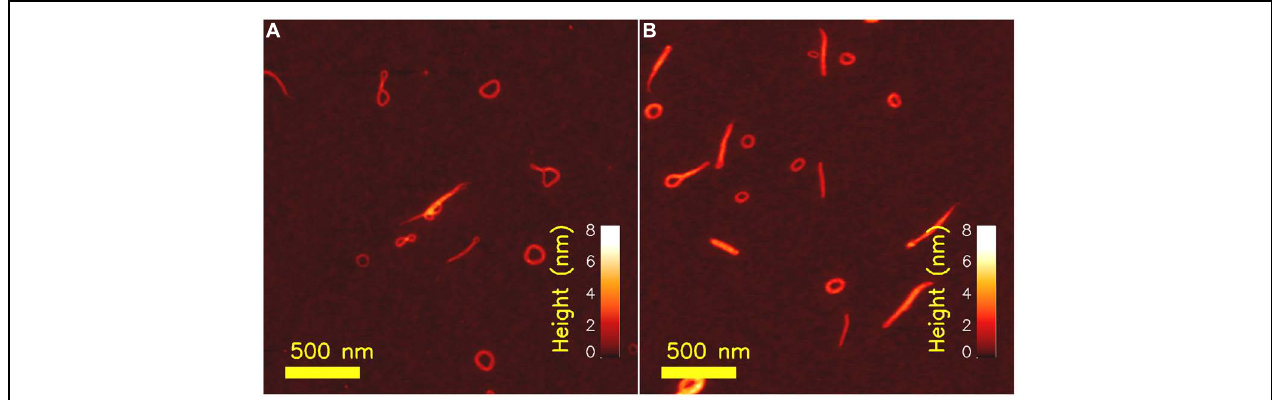
FIGURE 2 | Atomic force microcsopy topographs of chitosan– xanthan polyelectrolyte complexes (PECs) as prepared at low concentrations (xanthan concentration of 2 μ g/ml and chitosan with degree of acetylation 0.49 at a concentration of 10 μ g/ml)